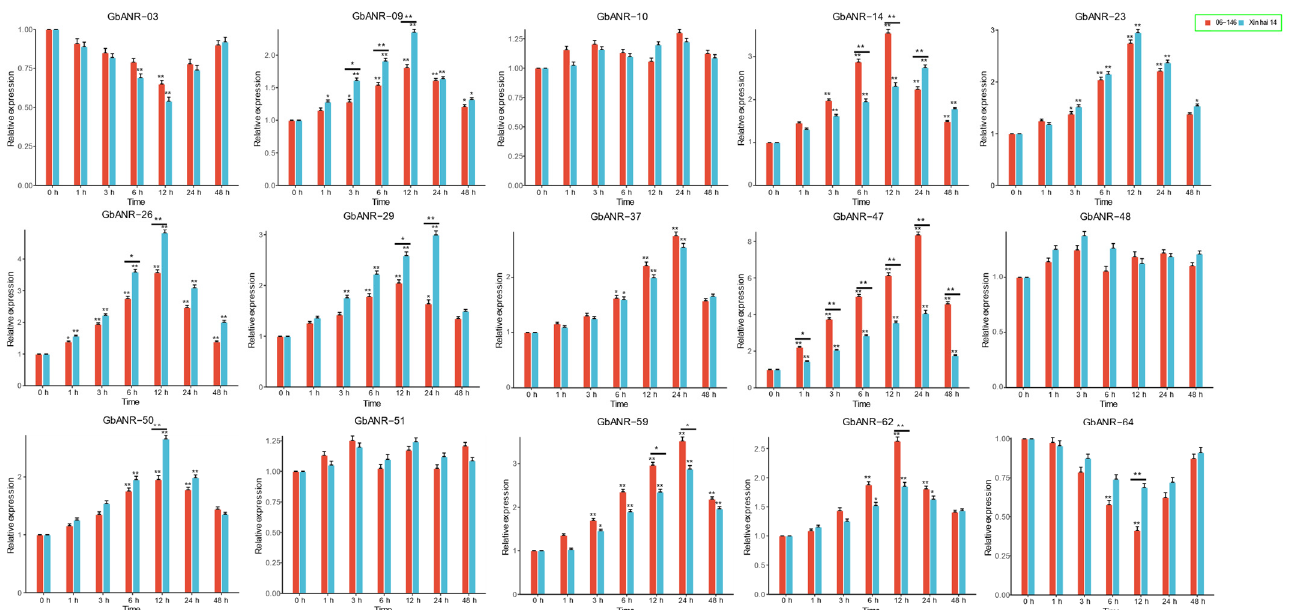
Figure 6. Expression analysis of the ANR gene in G. barbadense under FOV. The error bars represent the average of three replicates ± SEs. The difference from the control group is statistically significant at p < 0.05 (*) and p < 0.01 (**).